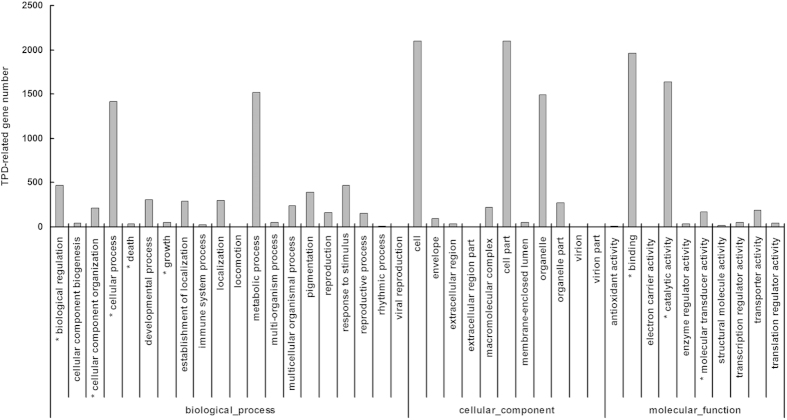
GO classifications of the TPD-related genes identified in this study.Asterisks indicate the enriched GO terms.